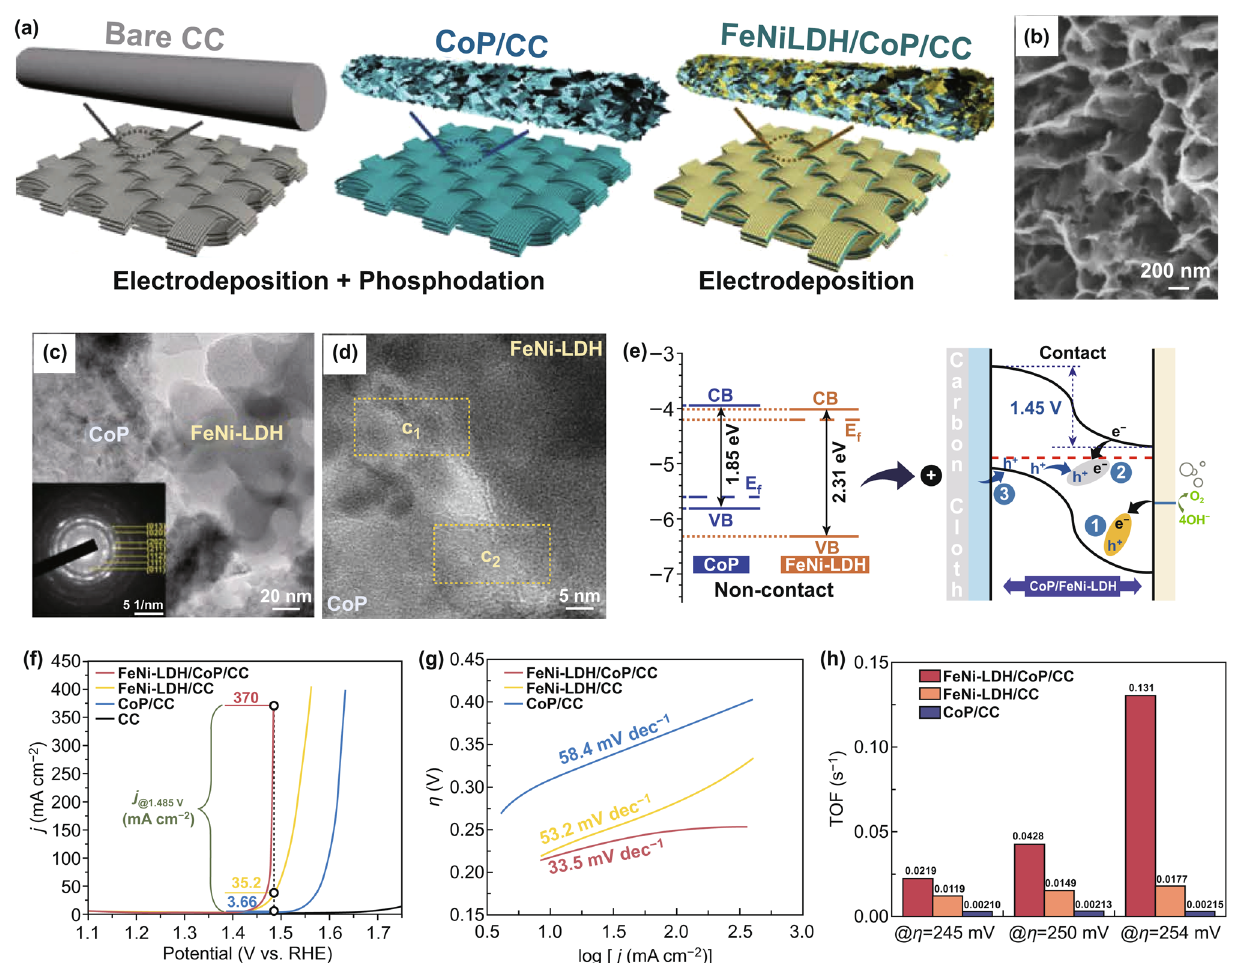
Fig. 16 a Schematic diagram of the fabrication process of FeNi‑LDH/CoP/CC composite electrodes. b SEM image, c , d HRTEM images and SAED pattern (inset of c ) of FeNi‑LDH/CoP NSs. e The energy diagrams of CoP and FeNi‑LDH and the electrocatalytic mechanism for OER in the FeNi‑LDH/CoP/CC p–n junction. f LSV curves of the different CoNi‑LDH@PCPs catalysts at 5 mV s −1 in 1 M KOH. g Tafel plots of the different catalysts. h TOF at different overpotentials. Reproduced with permission of Ref. [125]. Copyright 2019 Wiley–VCH Verlag GmbH & Co. KGaA,